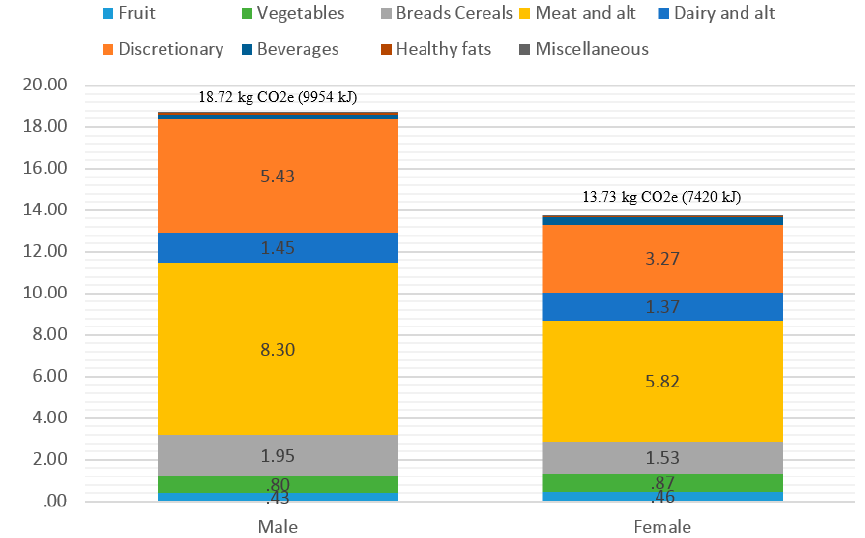
Figure 3. Cumulative average contribution of food groups to total dietary greenhouse gas emissions for Australian males and females.